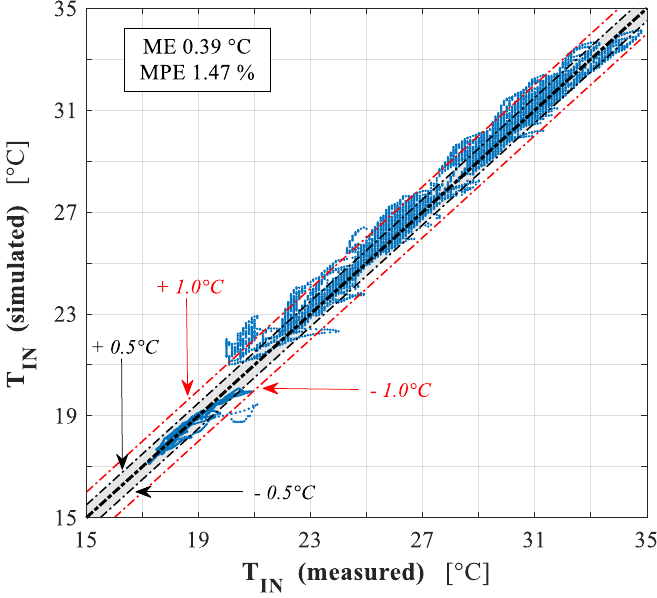
Figure 20. Indoor air temperature: simulated vs. experimental results (from February to November).